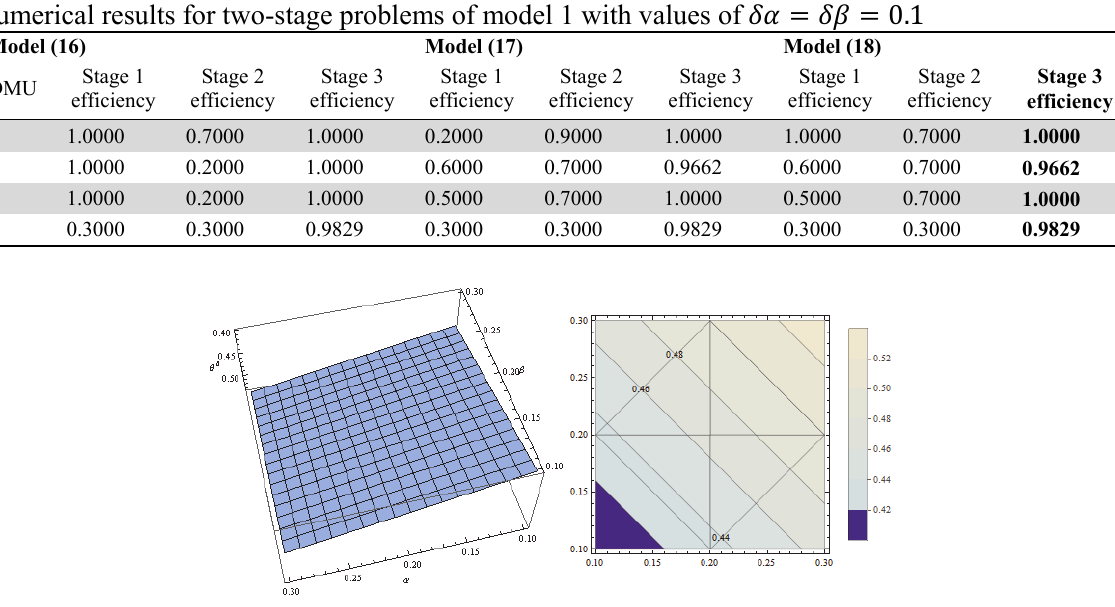
Fig. 3. Contour plot and numerical results for model